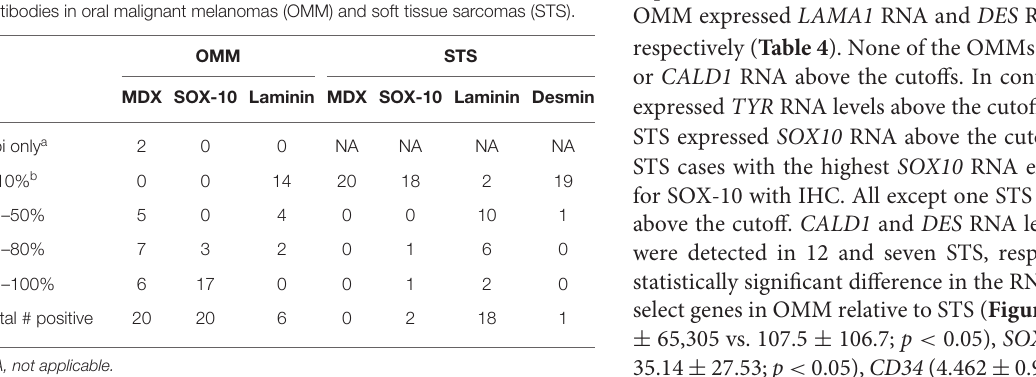
Frontiers in Veterinary Science |